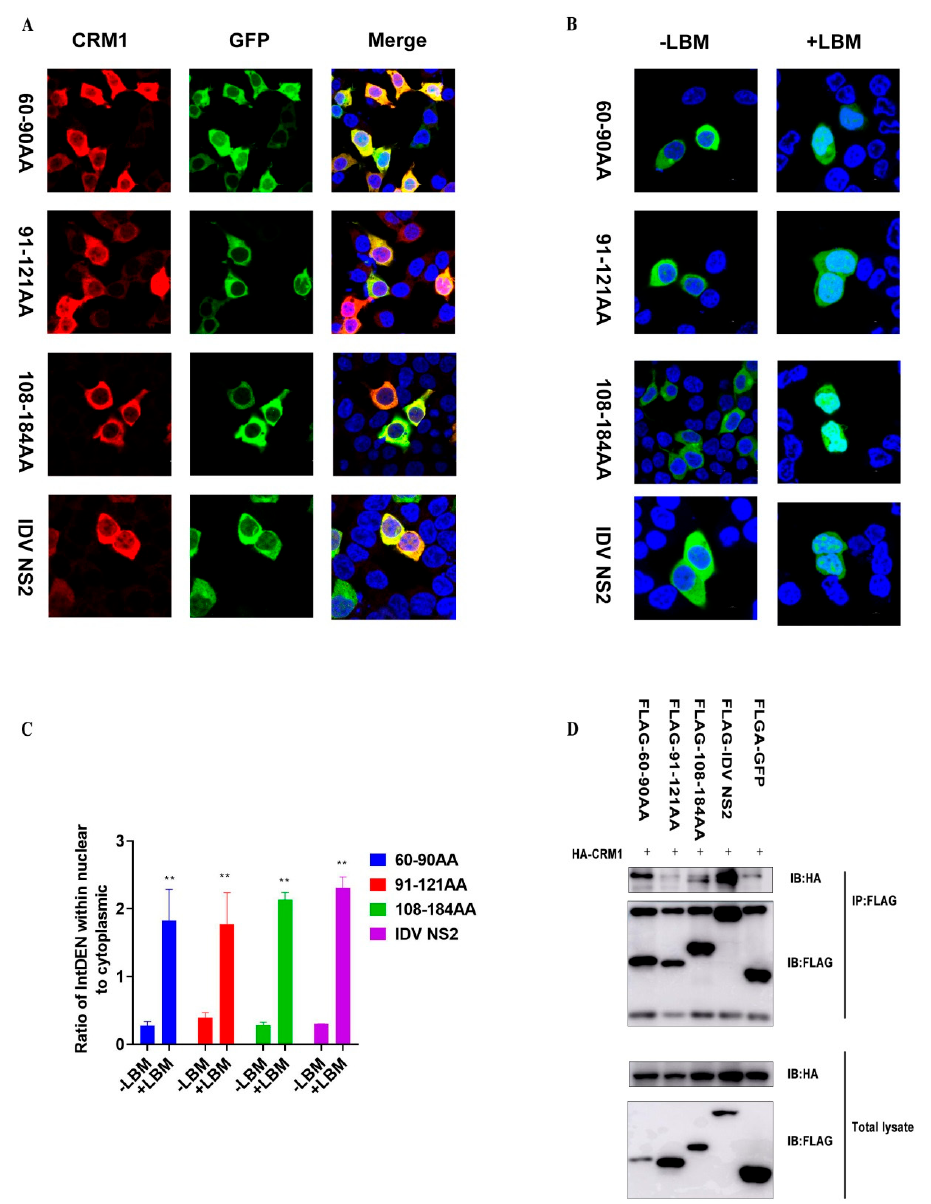
Figure 5. Investigation of the interaction of the three NESs of IDV NS2 with CRM1. ( A ) HEK293T cells cultured on slides were co-transfected with HA-CRM1 and eGFP-NES (60–90aa, 91–121aa, 108–184aa, and IDV NS2), and immunofluorescence confocal microscopy was performed 24 h later using anti- HA mouse monoclonal antibody followed by immunostaining with A546-labeled goat anti-mouse secondary antibody. Cells were stained with the 4, 6-diamidino-2-phenylindole (DAPI) and were examined via fluorescence microscopy. ( B ) HEK293T cells were transiently transfected with indicated plasmid pCAGGS-eGFP-NES(60-90aa), pCAGGS-eGFP-NES(91-121aa), pCAGGS-eGFP-NES(108- 184aa), pCAGGS-eGFP-IDV NS2 and then treated with or without 11 nM LMB at 6 h post-transfection. Cells were then fixed, permeabilized, and stained with the 4,6-diamidino-2-phenylindole (DAPI) and were examined via fluorescence microscopy at 24 h post-transfection. ( C ) Quantification of fluorescence signal was performed in ImageJ. (Statistical differences are labeled according to a one-